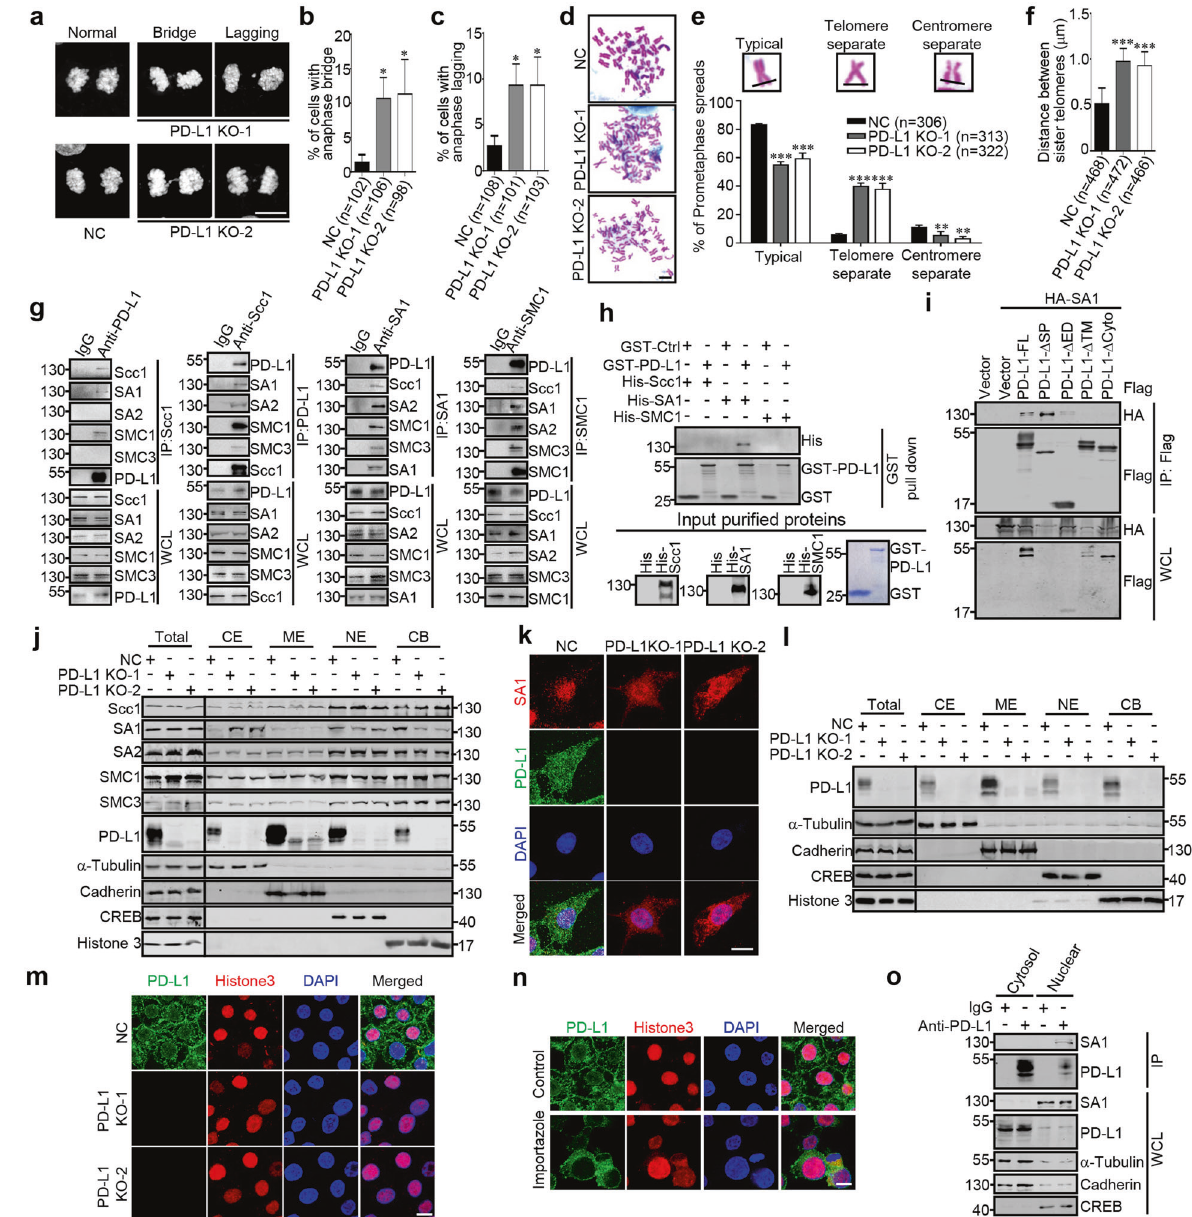
Fig. 1 a – c Representative images of anaphase bridge and lagging chromosomes in negative control (NC) and PD-L1 knockout (KO) RKO cells a . The percentage of cells with anaphase bridge ( b ) and lagging ( c ) were counted. d The indicated cells were subjected to chromosome spread assay and followed by Giemsa staining after treatment with colcemid for 2.5 h. Scale bar: 10 μ m. e Graphical representation of the frequency of each type of chromosome morphology. The classi fi cation was assigned when fi ve or more chromosomes in a spread displayed the indicated morphology. The cells with different chromosomal morphology were counted. f Graphical representation of the distances between sister telomeres and the length was determined by Image J software. g Total lysates from RKO cells were subjected to co-IP analyses with antibodies against PD-L1, Scc1, SA1, or SMC1, respectively. h In vitro interactions of puri fi ed GST-PD-L1 with His-Scc1, His-SA1, and His-SMC1. Coomassie staining was used to visualize GST or His fusion proteins. Western analysis with anti-His was used to visualize His-fusion proteins. i HEK293T cells transfected with the indicated plasmids were used for co-IP experiments. j Fractionations of subcellular proteins form NC and PD-L1 KO RKO cells were analyzed by western blotting using the indicated antibodies. CE cytoplasmic extract, ME membrane extract, NE nucleoplasm extract, CB chromatin-bound nuclear extract. k Immuno fl uorescence analyses were carried out by using anti-PD-L1 and anti-SA1 antibodies. Scale bar, 10 μ m. l Fractionations of subcellular proteins form NC and PD-L1 KO RKO cells were analyzed by western blotting using the indicated antibodies. m Immunostaining analyses were carried out by using anti-PD-L1 and anti-SA1 antibodies. Scale bar, 10 μ m. n Wild- type RKO cells were treated with or without Importazole (1 μ M) for 3 h, and subjected immuno fl uorescence assay with anti-PD-L1 and anti- Histone3 antibodies. Scale bar, 10 μ m. o Wild-type RKO cells were isolated to cytosol (containing cytoplasmic and membrane proteins) and nuclear fractions, and processed for co-IP assay with anti-PD-L1 antibody. Quantitative data from at least three independent experiments are shown as the mean ± SD. The sample size ( n ) is indicated. ∗ P < 0.05, ∗∗ P < 0.01 and ∗∗∗ P < 0.001, Student ’ s t -test